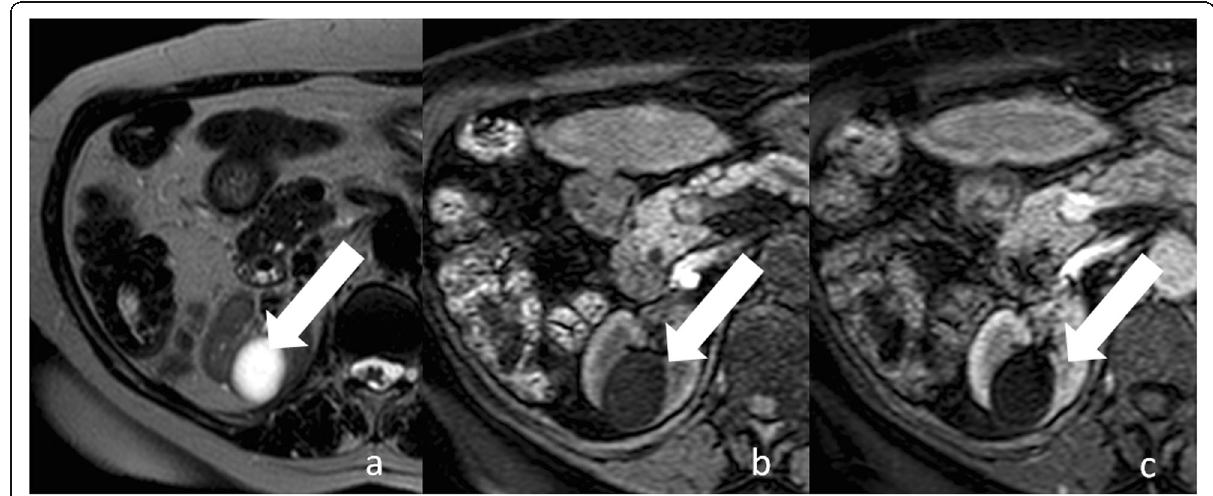
Fig. 4 Bosniak category I renal cyst. a Axial T2-weighted MR image shows a lesion (arrow) with strong hyperintensity and a thin wall. Corresponding axial non-enhanced ( b ) and contrast-enhanced ( c ) T1-weighted MR images show a hypointense lesion with a thin